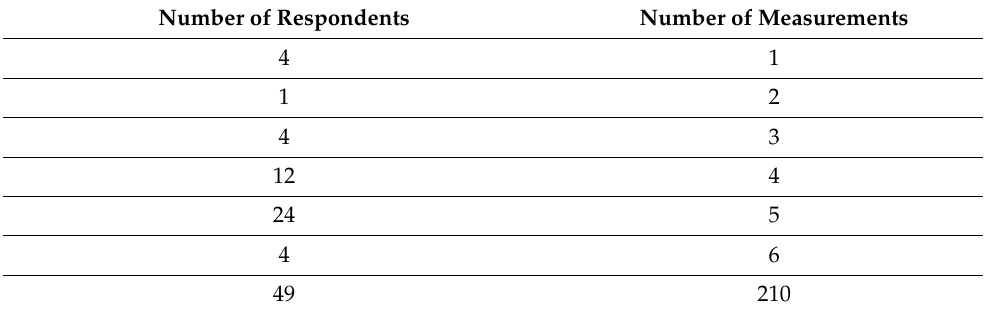
Table 1. The relationship between the number of completed measurements and the count of respondents.